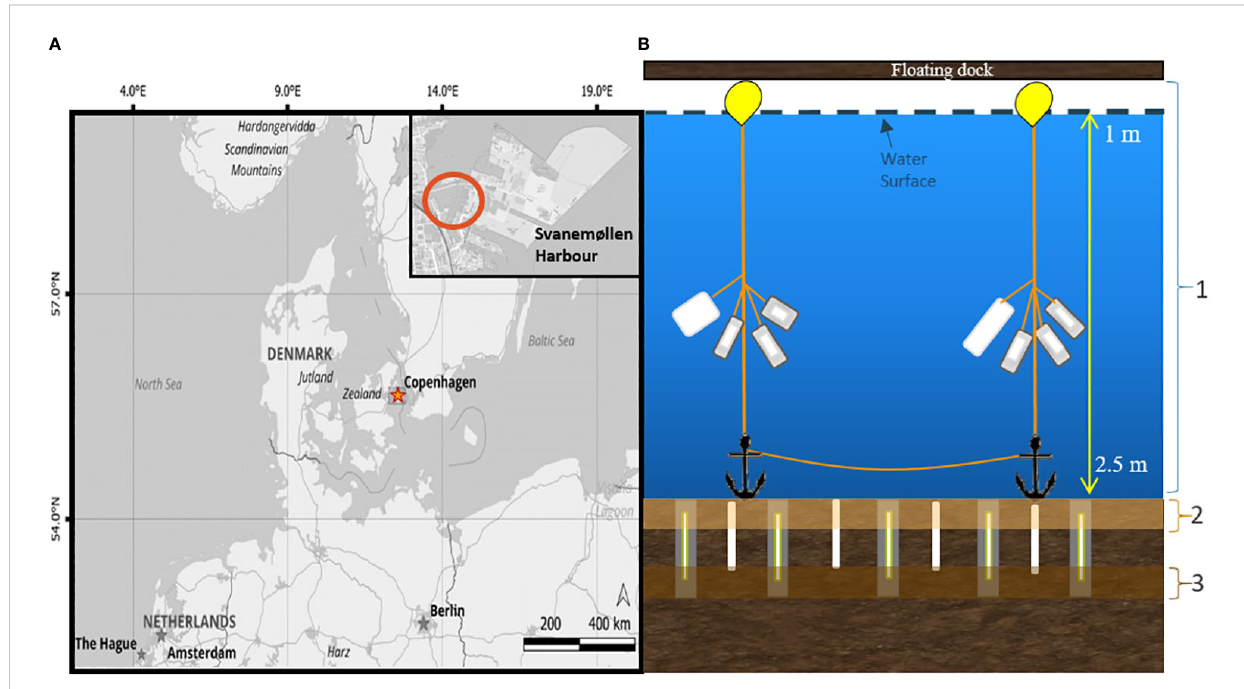
FIGURE 1 (A) Map of Denmark indicating the location of Svanemøllen Harbor in Copenhagen, along the Øresund Sound. Map data from OpenStreetMap, available at https://www.openstreetmap.org (B) Schematic diagram of the experimental set-up and compartments (marked 1,2,3). Cups with PE, PS, and wood inside were attached to lines with buoys, and anchored at the base. Stakes with PE, PS, and wood sandwiched inside were placed vertically in the sediment (grey), with one set of plastics (either PE or PS) placed in the sediment not in a stake (white). PE and PS were anchored from a fl oating dock af fi xed as a fl